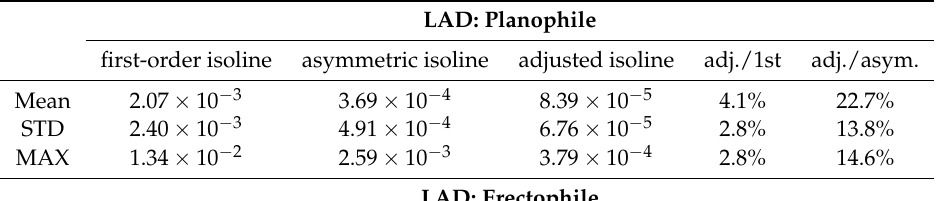
Table 4. Statistical distributions of the errors in the first-order, asymmetric-order, and adjusted aymmetric-order ( k opt = 1.29) isoline equations for the five LADs, including planophile, erectophile, plagiophile, extremophile, and uniform distributions.